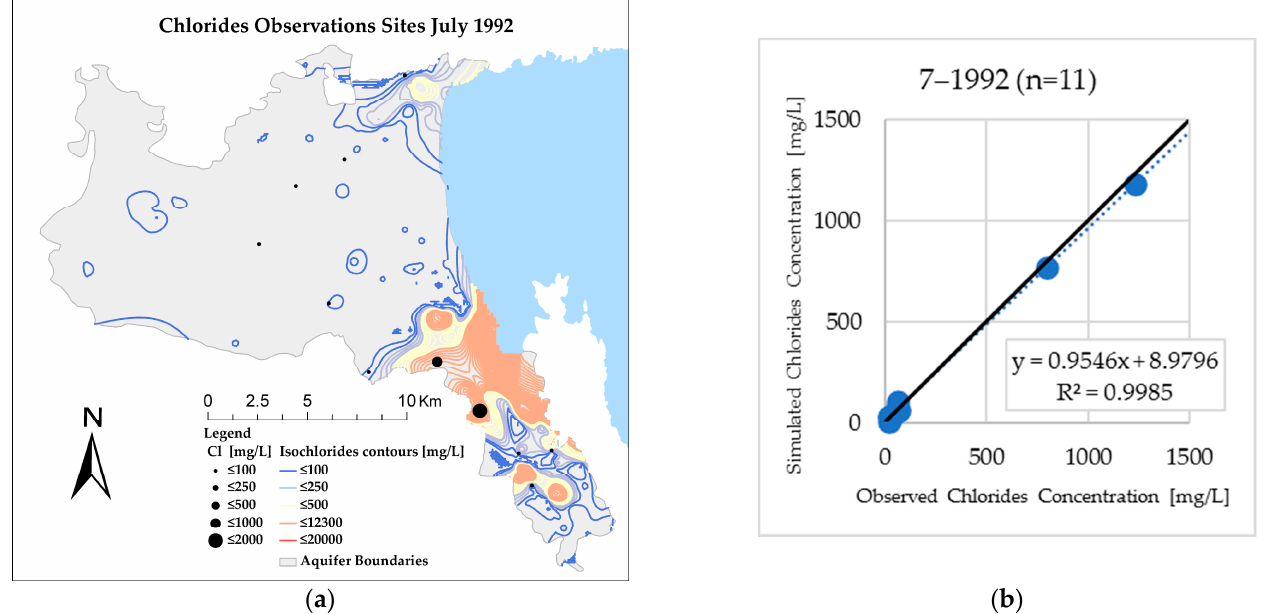
Figure 21. ( a ) Isochlorides contours for July 1992 and ( b ) scatterplot of simulated against observed chloride concentration values.